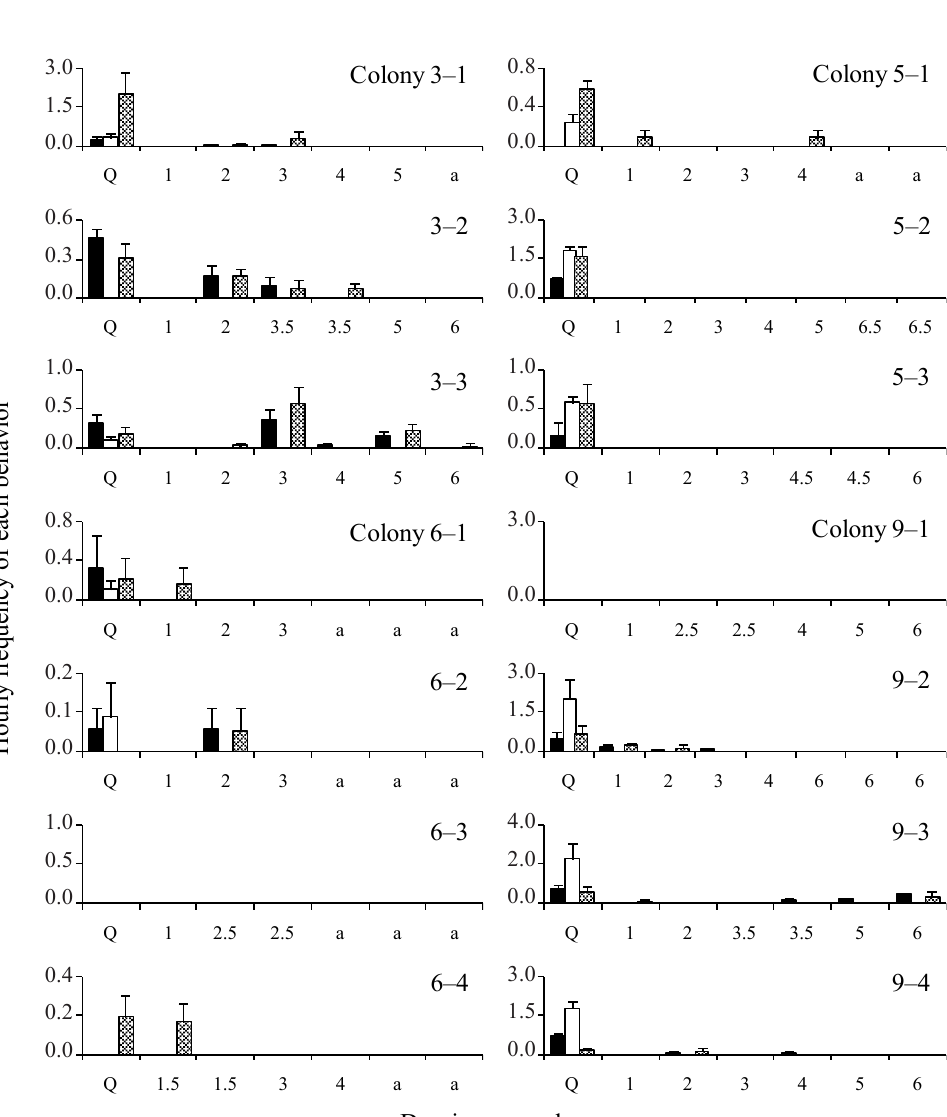
Fig S1 . Hourly frequencies (means and SE values) of ovipositing (solid), lateral vibrations (open), and abdominal rubbing (checked) performed by the queen (Q) and the first- to sixth-ranked workers. Dominance ranks were based on the dominance index (DI). No workers performed lateral vibrations. The number following the colony number indicates the analysis period. The letter “a” on the x-axis indicates no corresponding worker. Seventh- and lower-ranked workers occasionally performed ovipositing and abdominal rubbing: ovipositing, 0.06 ± 0.06 (mean ± SE) for the eighth-ranked worker during period 4 in colony 9; abdominal rubbing, 0.17 ± 0.00 for the eighth-ranked worker during period 3 in colony 5, and 0.08 ± 0.00 for the eighth-ranked worker during period 1 in colony